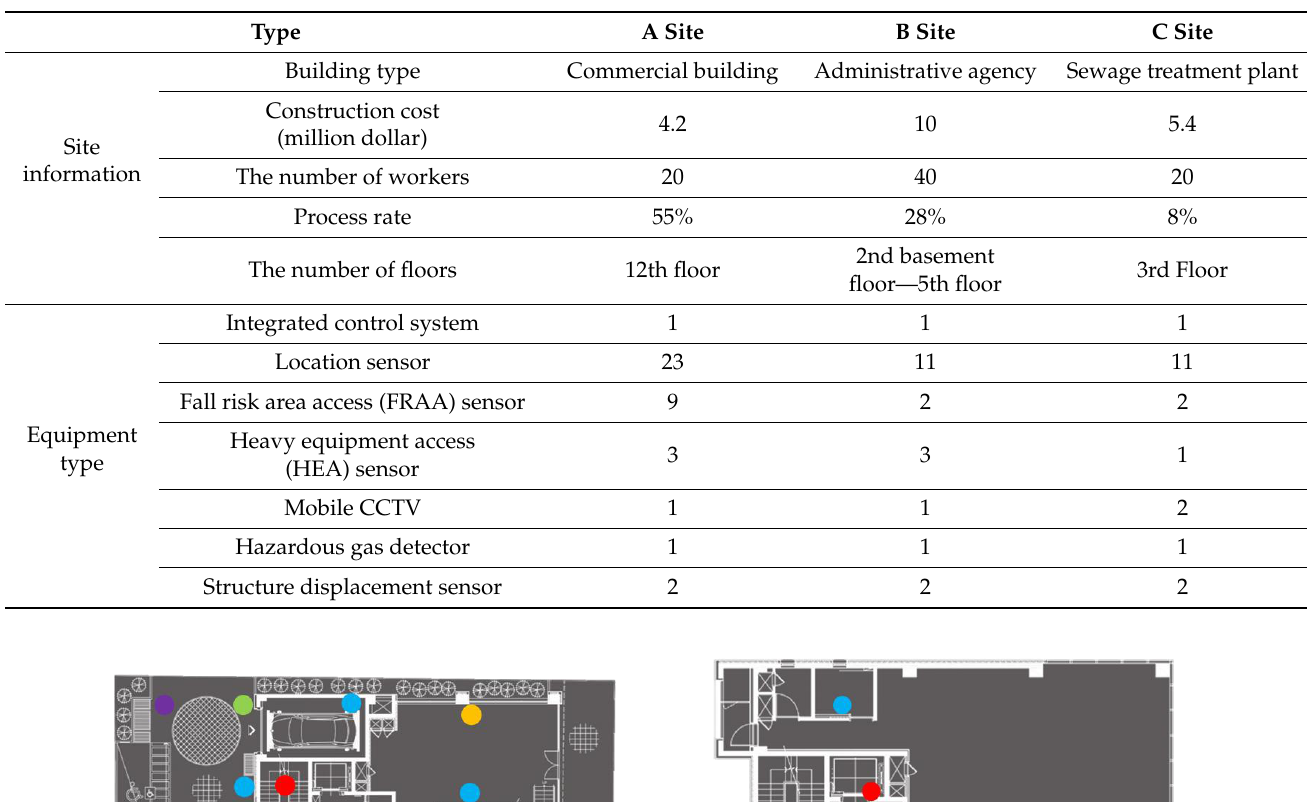
Table 4. Site information and installation equipment.